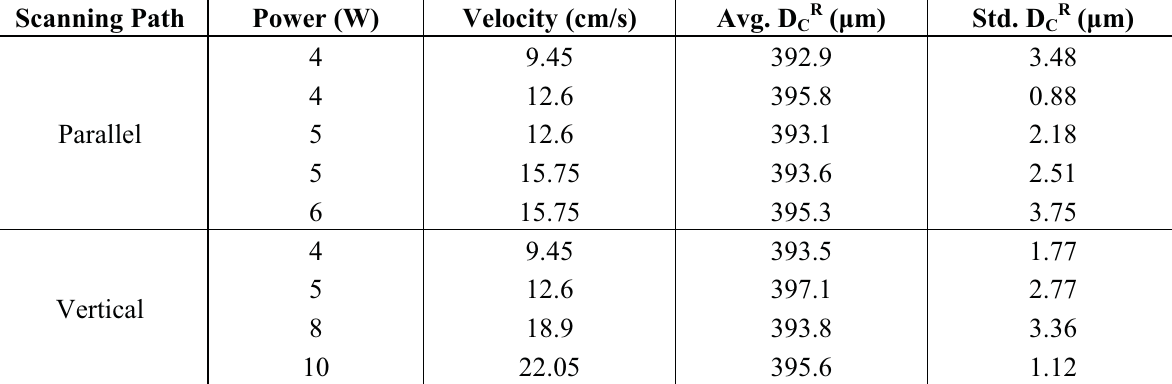
Table 2. Size analysis access parameters.